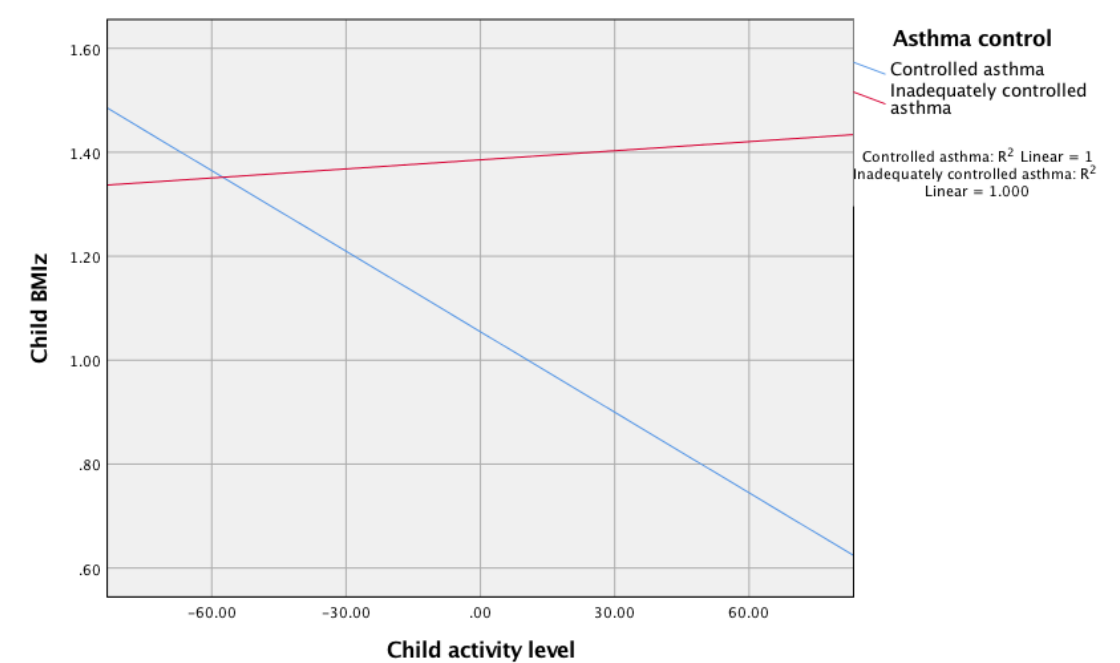
Figure 2. The relationship between child activity and child BMIz score moderated by asthma control.